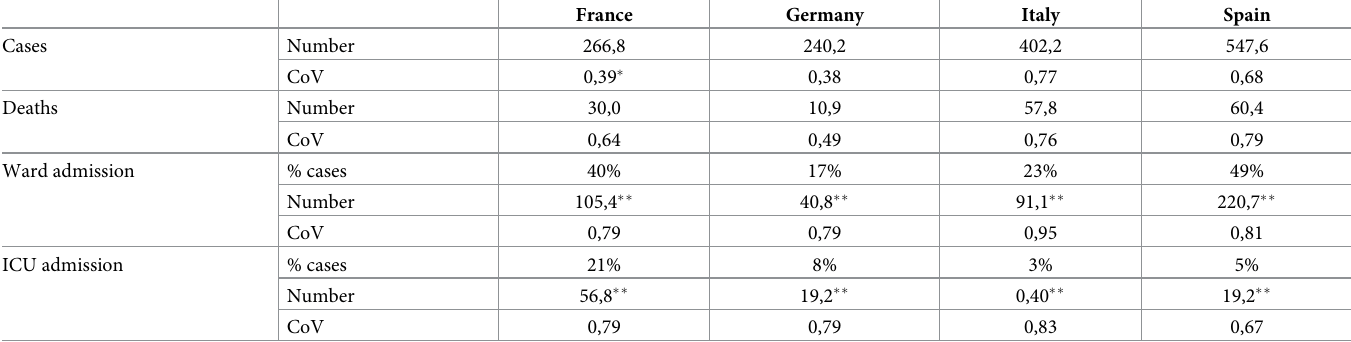
Table 3. Diffusion of the COVID-19 across the four analysed countries (as of 14 th of July 2020) considering: Cases, death and hospitalizations in wards and inten- sive care